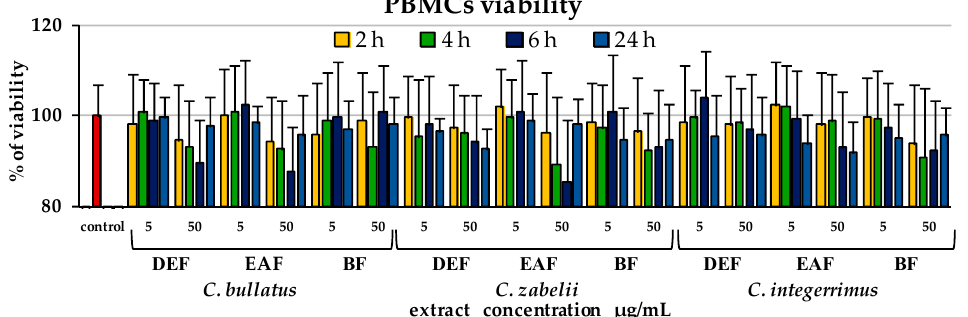
Figure 4. Viability of peripheral blood mononuclear cells (PBMCs) after 2, 4, 6 and 24 h incubation with the Cotoneaster leaf extracts at 5 and 50 µg/mL. Results are presented as means ± SD ( n = 10). Extracts: DEF, diethyl-ether fraction; EAF, ethyl acetate fraction; BF, n -butanol fraction.